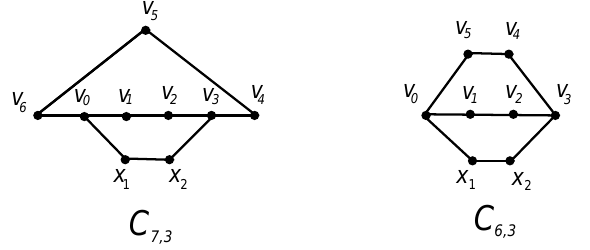
Figure 1. Two 2-connected graphs whose line graphs have no